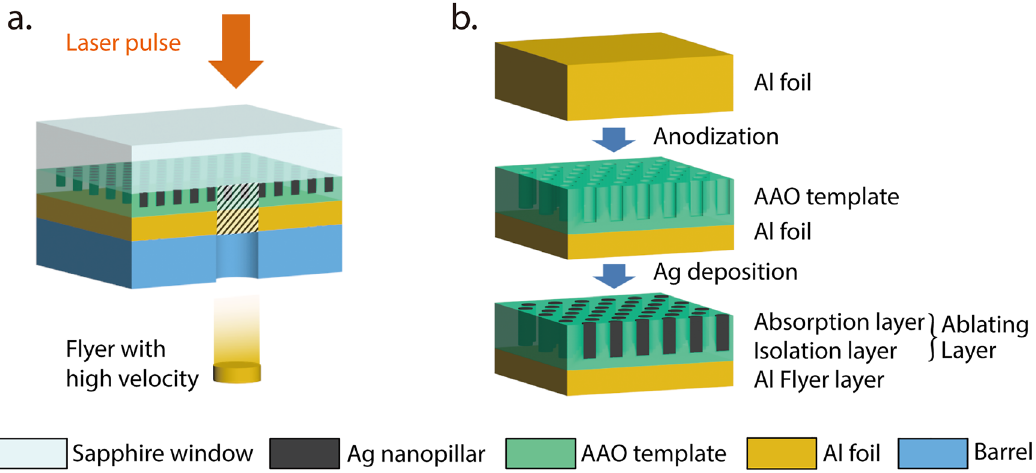
Figure1: (a) Thearchitectureof theAPA-AAOenhancedLDF,includea dielectricwindow(lightgreen),theablatinglayer(blackandgreen),the flyer layer (yellow), and an accelerated chamber (blue). The ablating and flyer layers are fabricated by the method shown in (b), and then the dielectricwindowandtheacceleratedchamberareplacedcloselyonthetop andbottomsidesrespectivelyto formanintegratedflyer;(b)The pretreatment and fabrication procedures of the APA-AAO absorber, include the pretreatment of Al foil, fabrication of AAO templets by a two- step anodization approach, and the electrochemical deposition of Ag in AAO